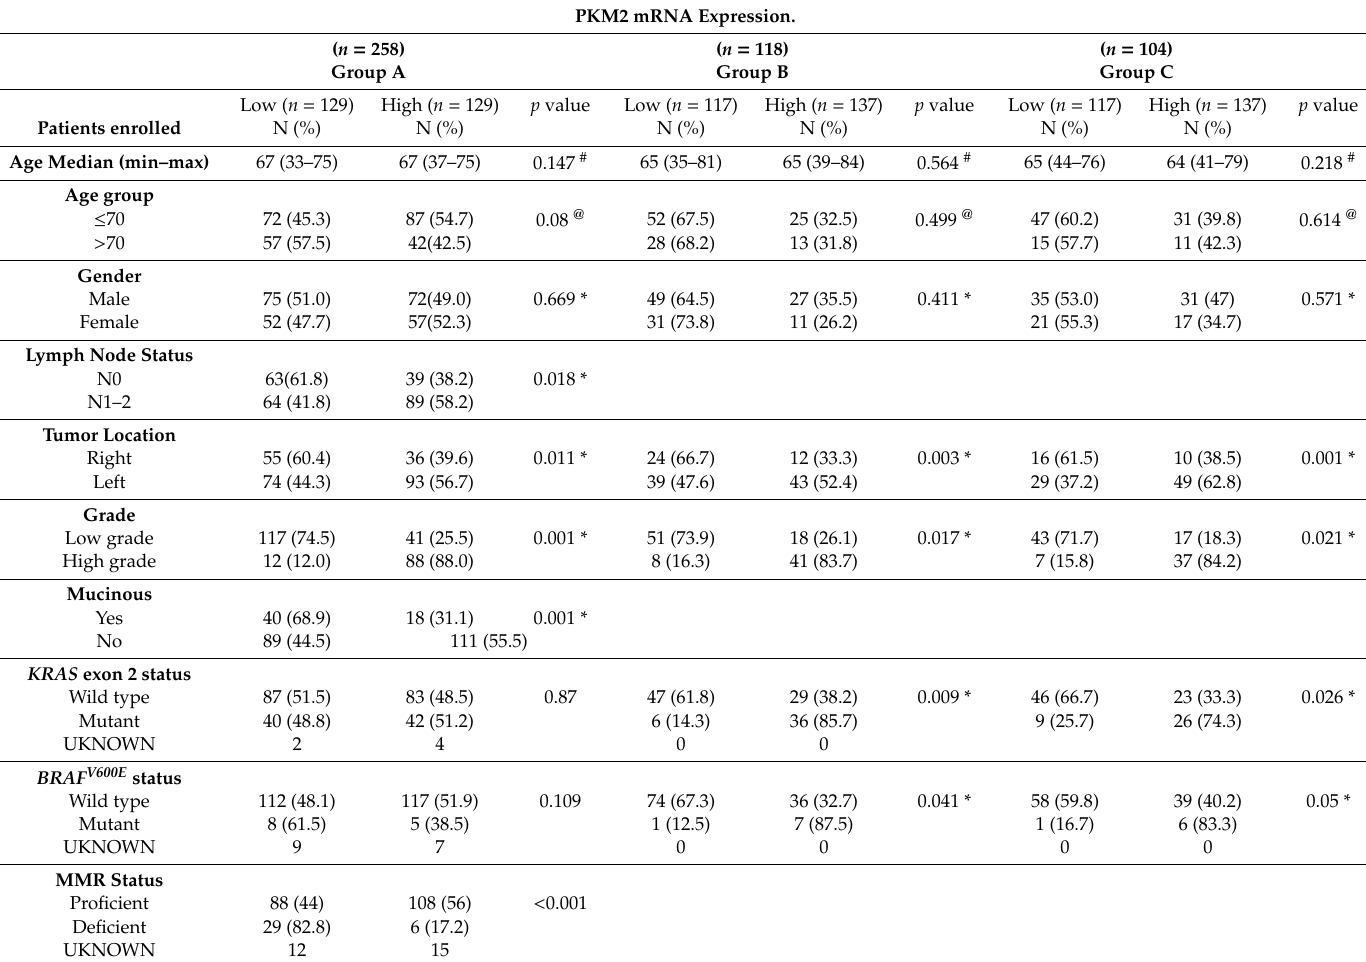
Table 2. M2 isoform of pyruvate kinase (PKM2) mRNA